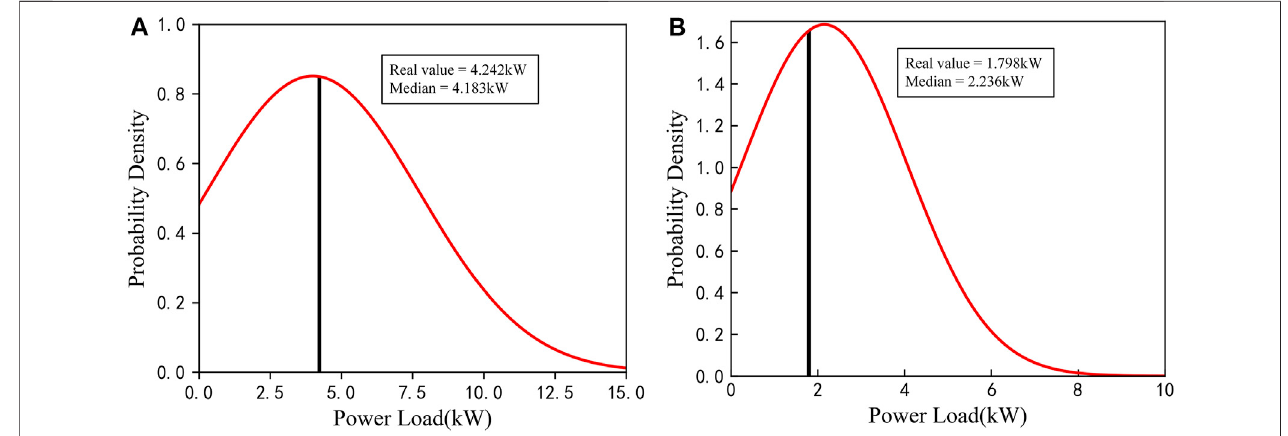
FIGURE 12 | ConvLSTM-MDN model predictive distribution and real values for a day at (A) 10:00 and (B) 13:00 in experiment